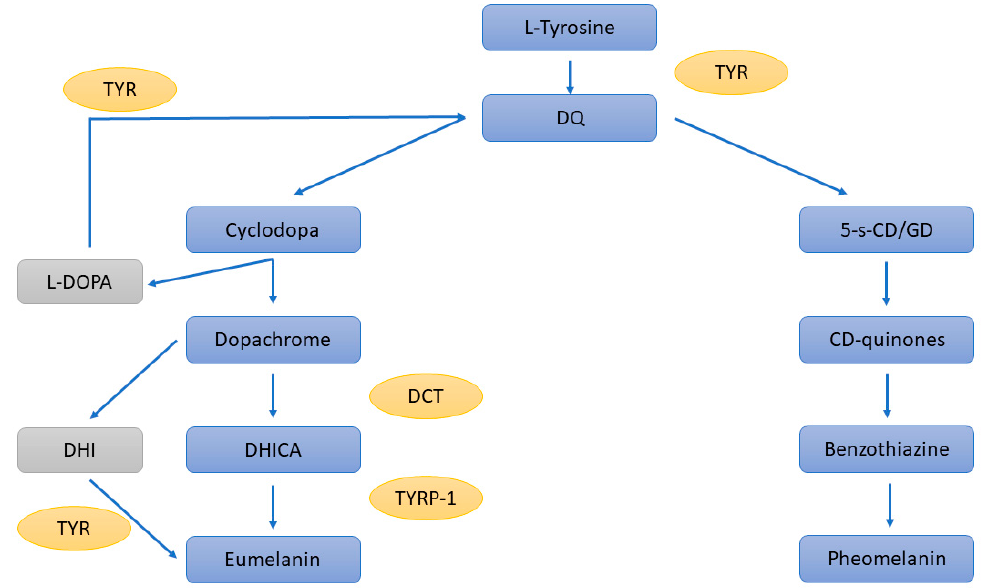
Figure 1. Schematic representation of the cascade of melanin synthesis. TYR = tyrosinase, DCT = dopachrome tautomerase, TYRP-1 = tyrosinase-related protein 1, L-DOPA = dihydroxyphenylalanine, DHI = dihydroxyindole, DHICA = dihydroxindole-2-carboxylic acid, 5-s-CD/GD = 5-S-cysteinyldopa or glutathionyldopa, CD-quinones = cysteinyldopa-quinones.